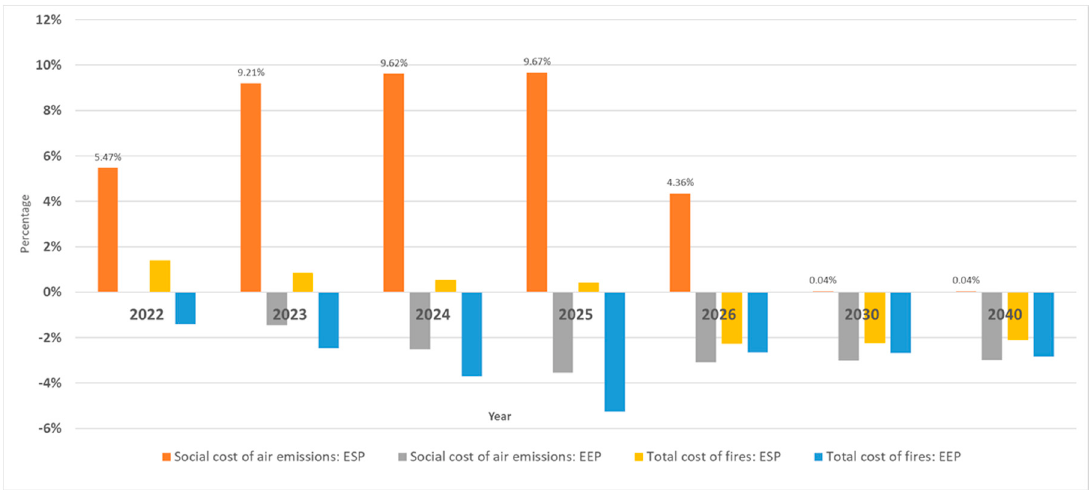
Figure 9. Percentage change in the social cost of air emissions in the ESP and EEP scenarios. Source: Authors. The changes in the health costs of paraffin use, burns and ingestion show a similar trend, whereby costs increase in the ESP scenario, with the largest changes occurring in 2022 (Figure 10a). The energy efficiency policy shows a decline in the changes related to the health costs of paraffin use, burns and ingestion (Figure 10b).